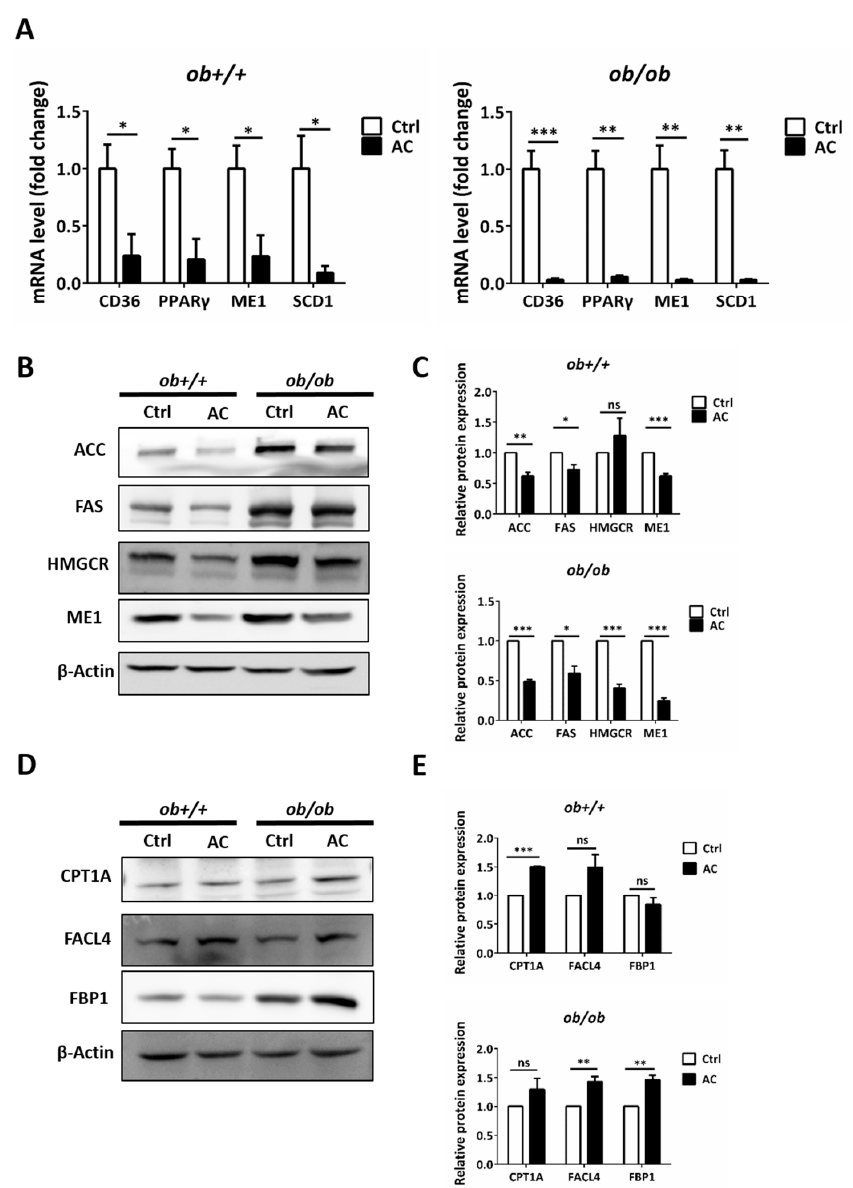
Figure 3. AC reduces hepatic lipogenesis and increases gluconeogenesis by regulating related-genes or protein in ob +/+ and ob / ob mice. ( A ) The relative mRNA expression of CD36, PPAR γ , ME1, and SCD1 were compared between ob +/+ Ctrl or ob / ob -Ctrl mice. ( B , D ) Immunoblot analysis of proteins involved in lipogenesis, β -oxidation, and gluconeogenesis. ( C , E ) Quantification of protein expression and comparison between ob+/+ -Ctrl and ob/ob -Ctrl mice. All data are expressed as mean ± SEM, * p < 0.05, ** p < 0.01, *** p < 0.001. Non-significant; ns. n = 4–8 mice in each group. All experiments were repeated thrice.